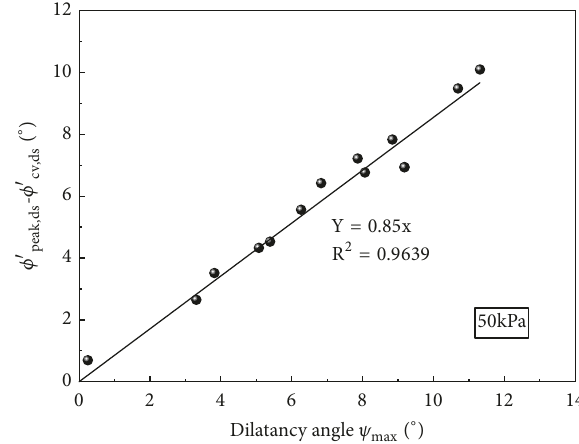
Figure 12: Peak friction angle 𝜙 󸀠 𝑝𝑒𝑎𝑘,𝑑𝑠 versus maximum dilation angle 𝜓 𝑚𝑎𝑥 (50